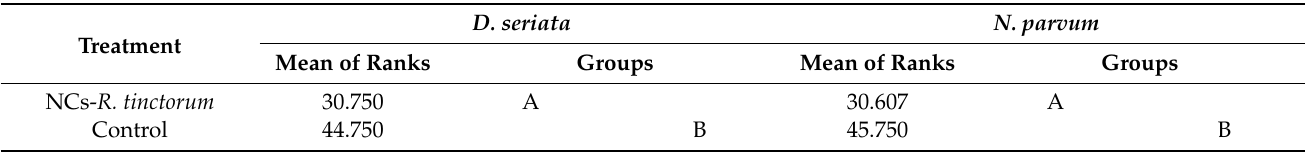
Figure 7. Hypothetical assembly of the methacrylated COS and methacrylated g-C 3 N 4 moieties.